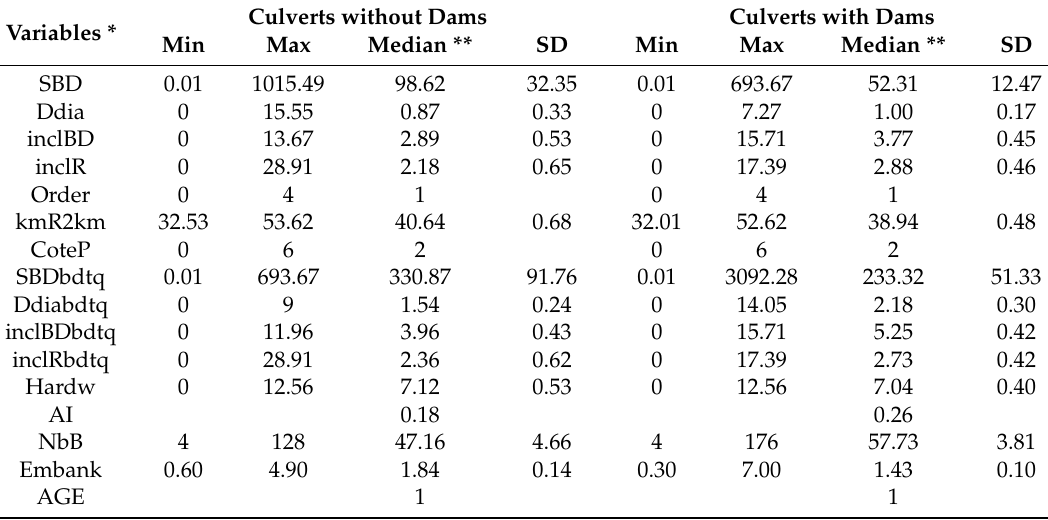
Table 2. Descriptive data for 12 study variables that were used to explain the presence or absence of dams.